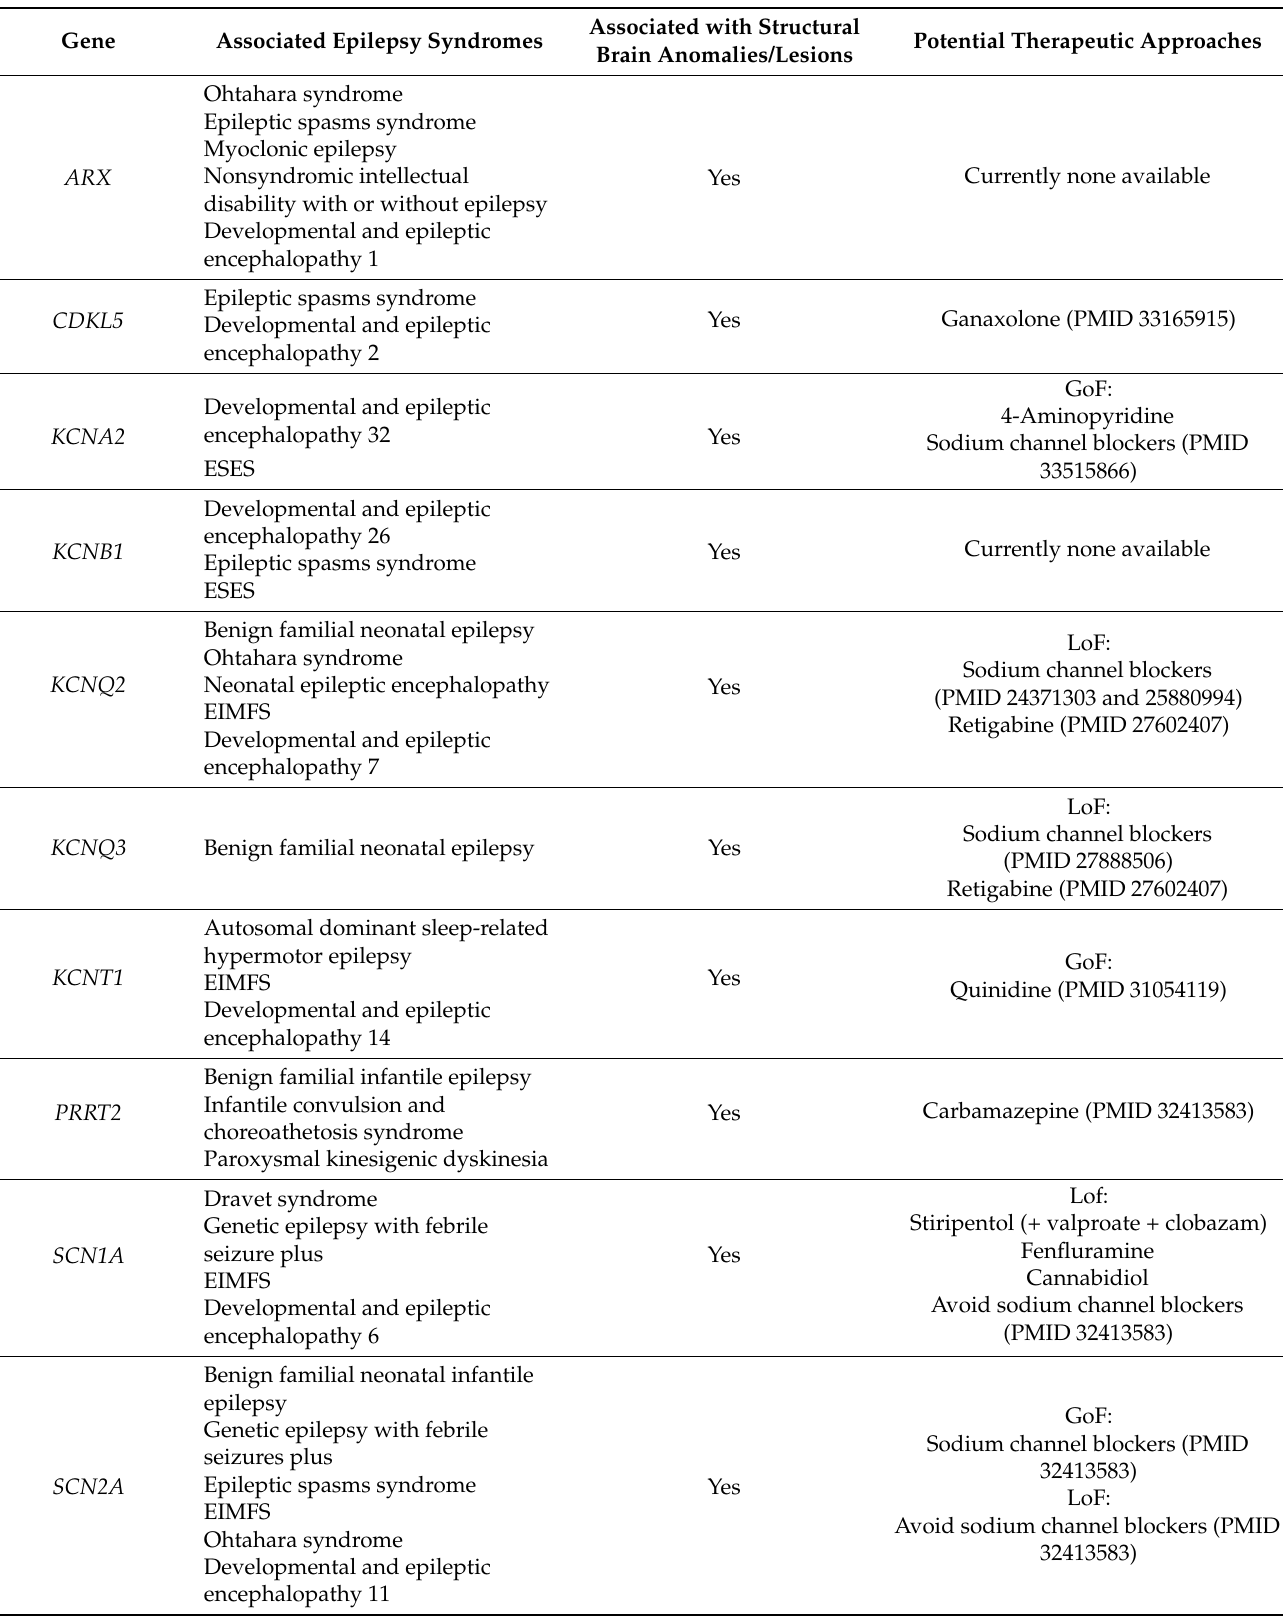
Table 2. Genotype–phenotype relationship of the most recurrent genes associated with benign familial neonatal and/or infantile epilepsies and early-onset developmental and epileptic encephalopathies together with potential precision therapy